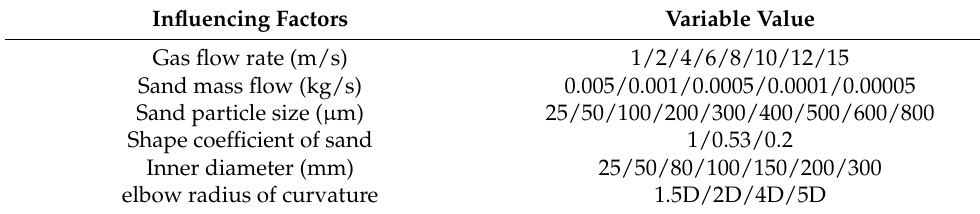
Table 2. Parameters of the impact angle function.